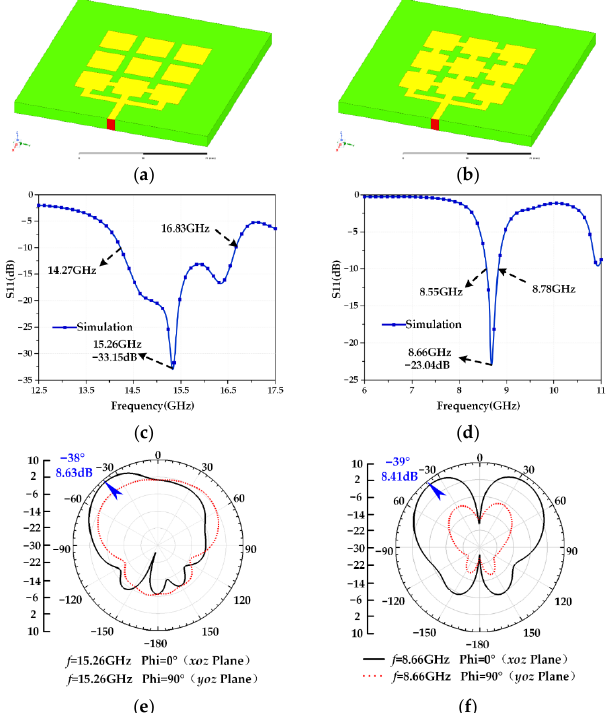
Figure 2. ( a ) Mode 1 antenna structure; ( b ) Mode 2 antenna structure; ( c ) S11 curve of Mode 1 antenna; ( d ) S11 curve of Mode 2 antenna; ( e ) radiation pattern of Mode 1 antenna; ( f ) radiation pattern of Mode 2 antenna.